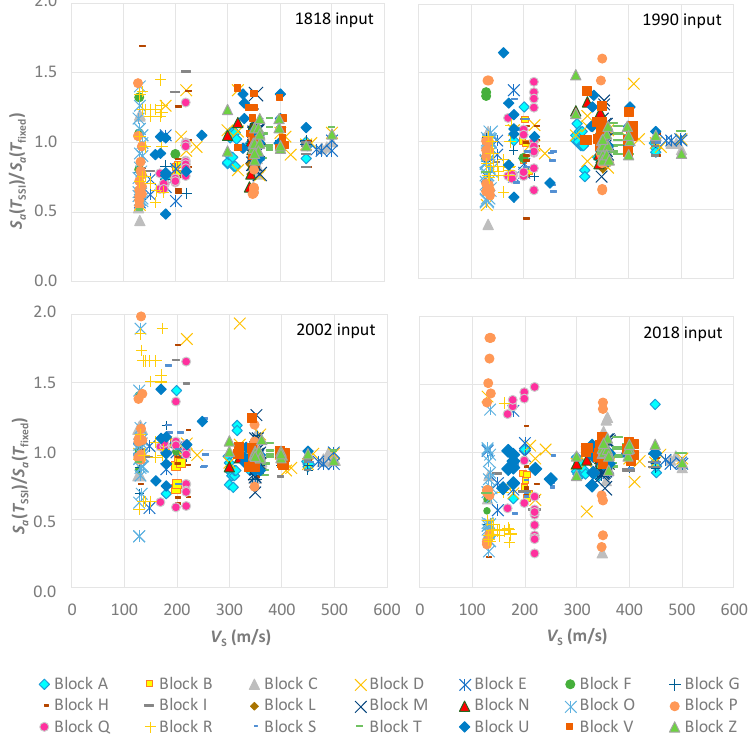
Figure 25. S a ( T SSI )/ S a ( T fixed ) ratios versus shear waves velocities V s for the south Old Town area. Figure 25. S / S a ( T SSI ) a ( T fixed ) ratios versus shear waves velocities V s for the south Old Town